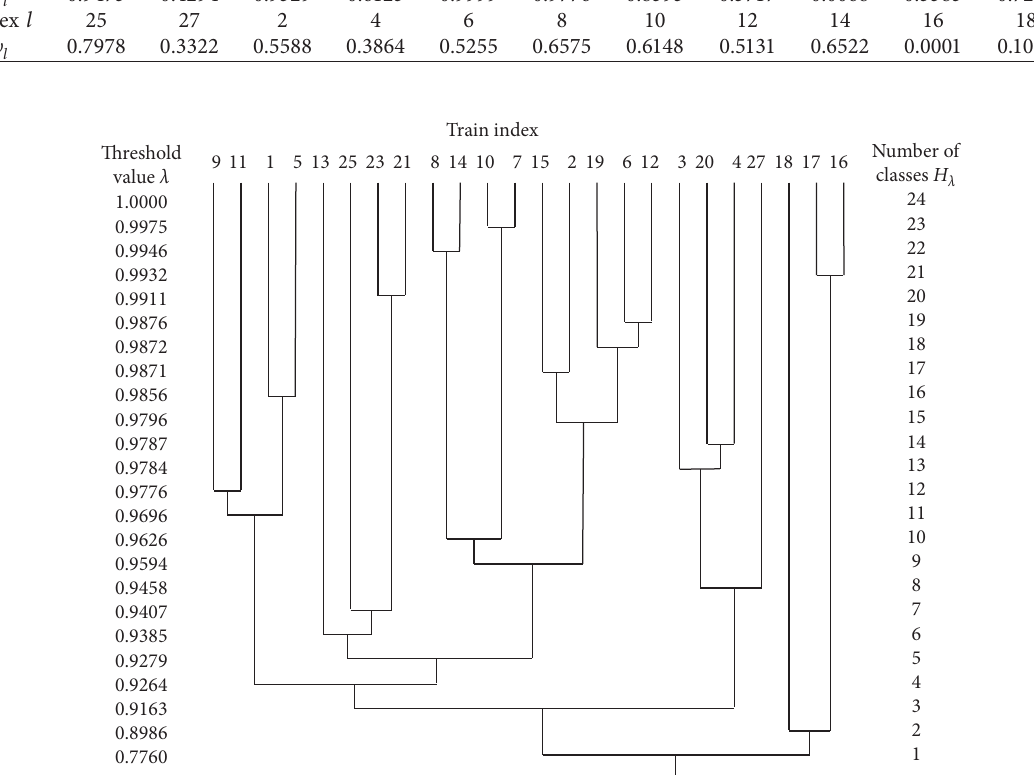
Figure 8: Train hierarchies based different threshold λ